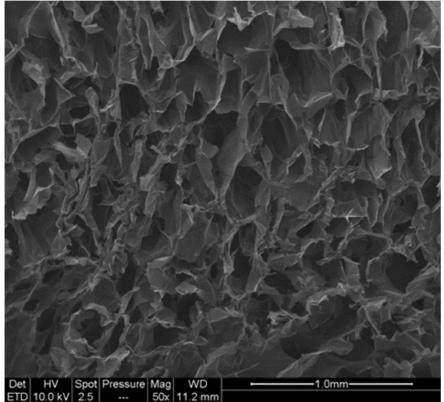
Figure 5. SEM images of the cross-section of toCNF